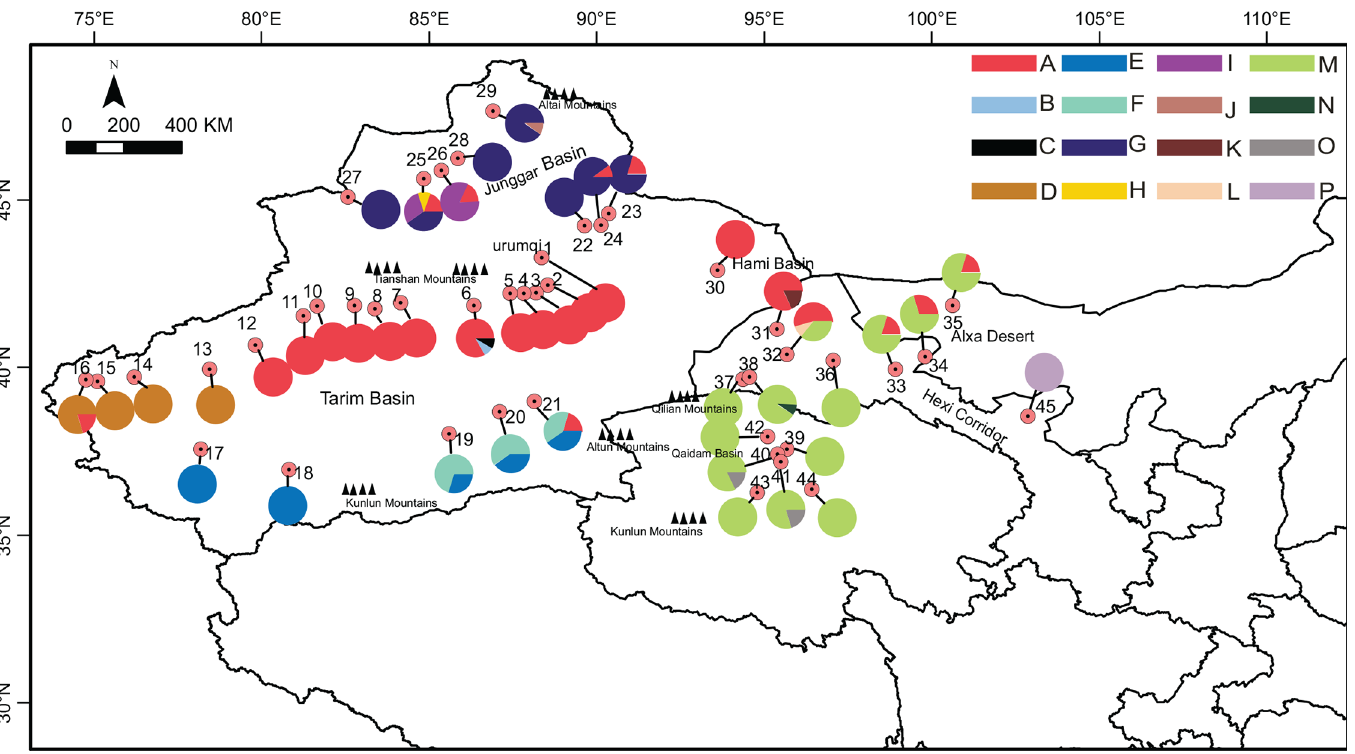
Fig 1. Geographical distribution of Ephedra przewalskii in China, population numbers and haplotypes of E . przewalskii correspond to those in S1 Table and S2 Table respectively, pie-charts represent haplotype frequency. Xinjiang Province includes Urumqi, Tarim basin, Junggar basin, and Hami basin (i.e. populations 1 –